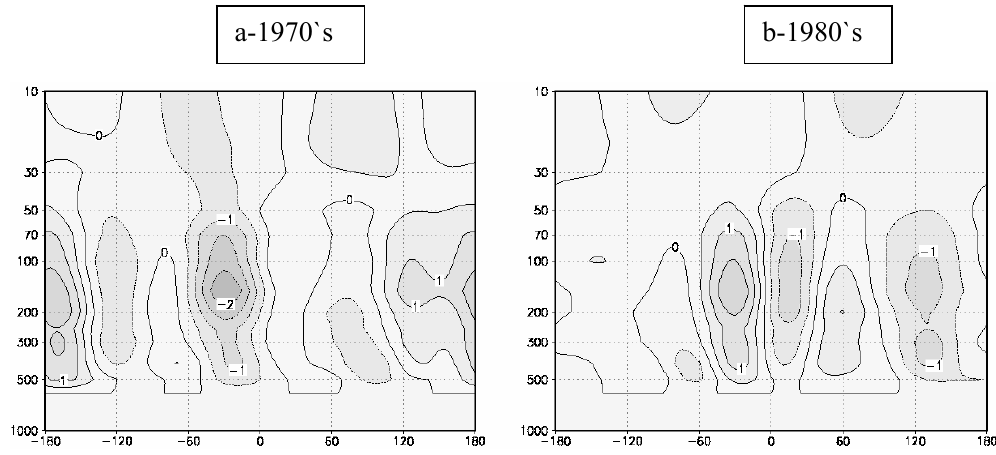
Fig. 6. Altitude-longitude cross section of modelled ozone distribution (DUkm − 1 ) at 50 ◦ N latitude for January. Figure 6: Altitude-longitude cross section of modelled ozone distribution (DU/km) at an increase over North America and a decrease over the Far 50° N latitude for January. East. In the 70-hPa layer the North America pattern is still significant as well as the Far East pattern. The negative trend over Greenland is not significant. A comparison with the ERA-40 geopotential height change in 300 hPa and 70 hPa (not shown) reveals similar structural